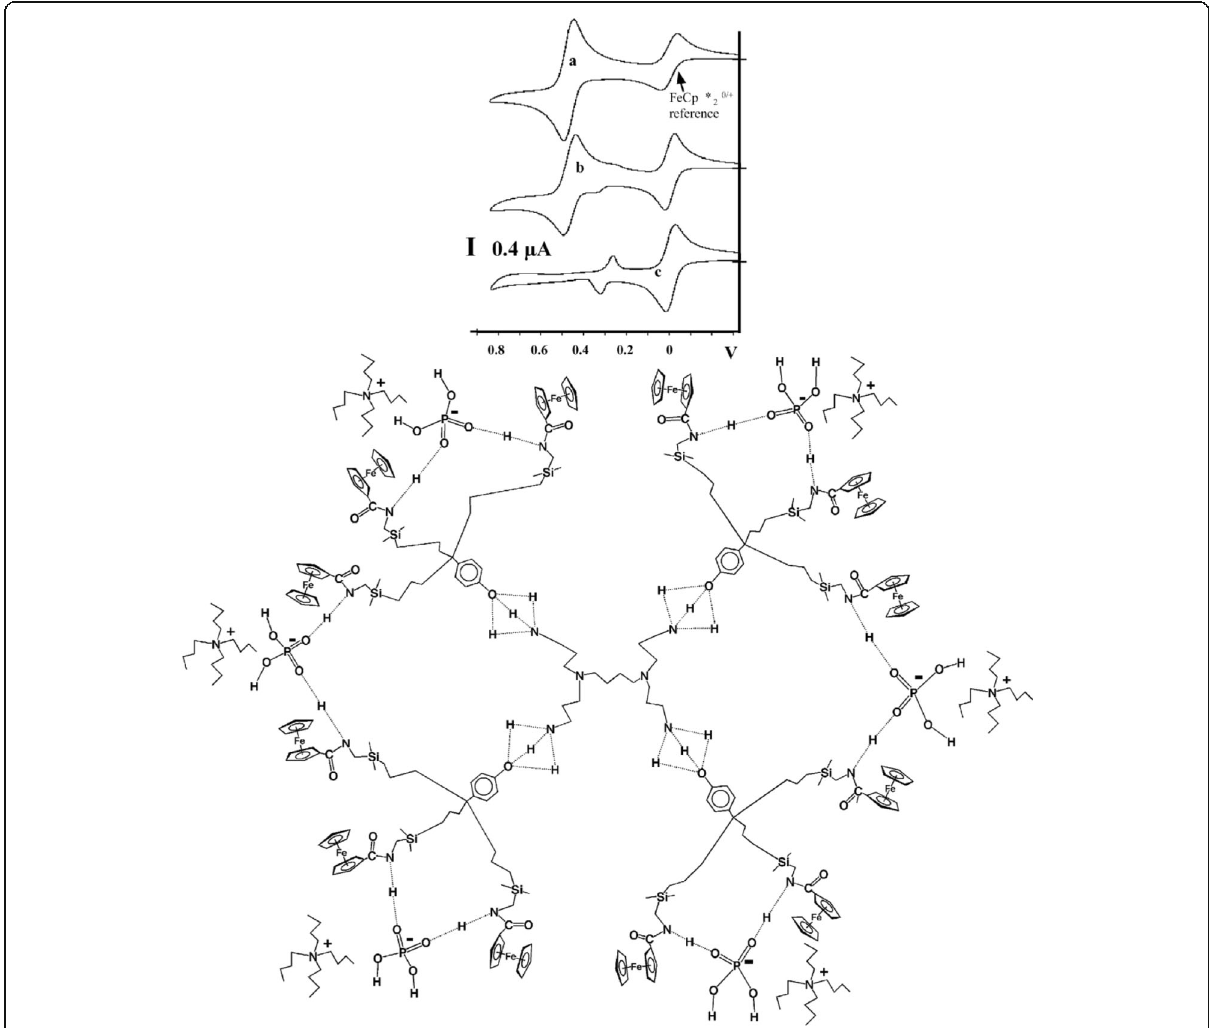
Fig. 4 Sensing of H 2 PO 4 − by the supramolecular metallodendrimer: Titration using cyclic voltammetry in CH 2 Cl 2 (Pt, 0.1 M [ n Bu 4 N][PF 6 ], reference FeCp* 2 (Cp* = η 5 -C 5 Me 5 ) of the supramolecular amidoferrocene dendrimer by [ n Bu 4 N][H 2 PO 4 ]: (a) before addition of [ n Bu 4 N][H 2 PO 4 ]; (b) after addition of 0.4 equiv.; (c) 0.5 equiv. The dramatic intensity drop at the equivalent point shows the sharp decrease of the diffusion coefficient reflecting the sudden formation of the large supramolecular assembly proposed here in which each H 2 PO 4 − group binds two amidoferrocene groups corresponding to the observed stoichiometry [134]. Copyright 2003 American Chemical